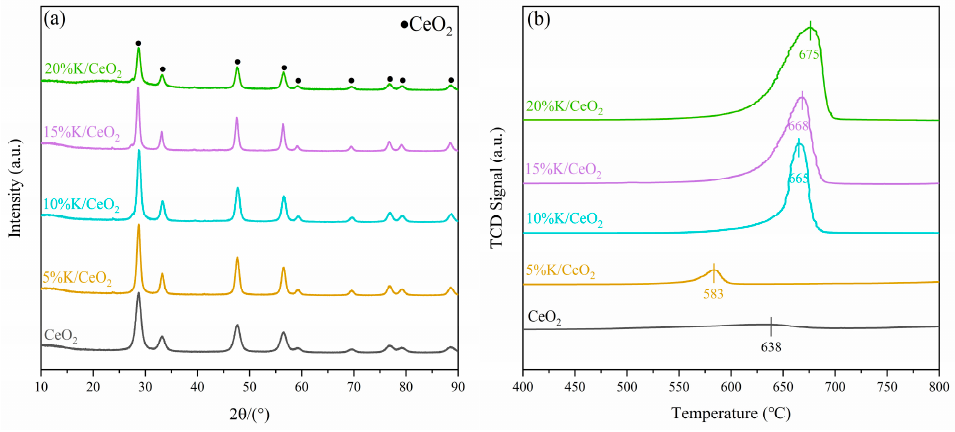
Figure 4. Characterization of n%K/CeO 2 . ( a ) XRD; ( b ) H 2 -TPR ( n = 0, 5, 10, 15, 20). The H 2 temperature programmed reduction (H 2 -TPR) test was performed to detect the The basicity of the catalyst surface plays a key role in the activation of ethylbenzene reducibility of the CeO 2 and n%K/CeO 2 . The H 2 -TPR curves are shown in Figure 4b. The curve of CeO 2 was one reduction peak at 638 ◦ C, which was ascribed to the reduction of the CeO 2 surface lattice oxygen [13,37,38]. When a small amount of K was loaded (5%K/CeO 2 ), the reduction peak at 638 ◦ C shifted to a lower temperature (583 ◦ C), and the intensity of the peak increased slightly. Compared to the pure CeO 2 , the reduction temperature of the surface lattice oxygen rose by about 30 ◦ C for the 10%K/CeO 2 catalyst, but